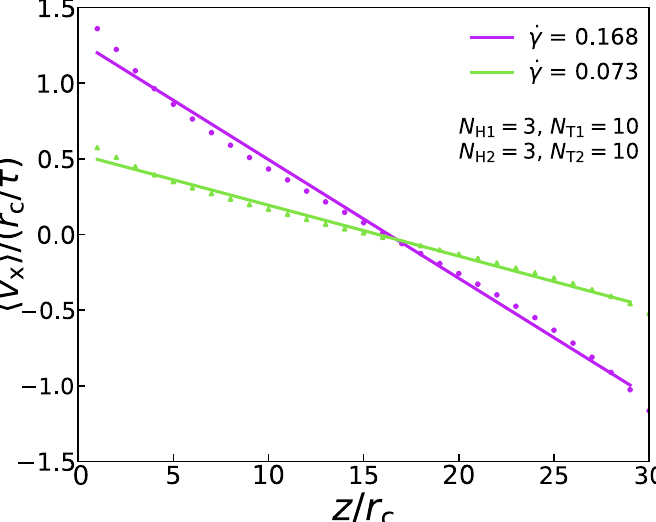
Figure 2. An example of velocity profile at ˙ γ = 0.168 and ˙ γ = 0.073 in the simulation